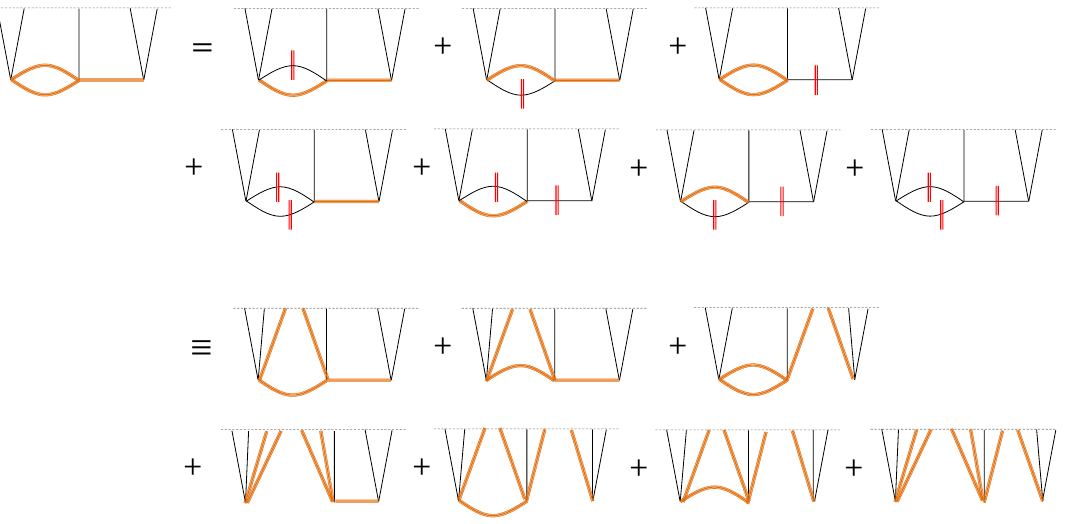
Figure 1 . An example of the Cosmological Cutting Rules, applied to a particular diagram that contributes to the wavefunction of the